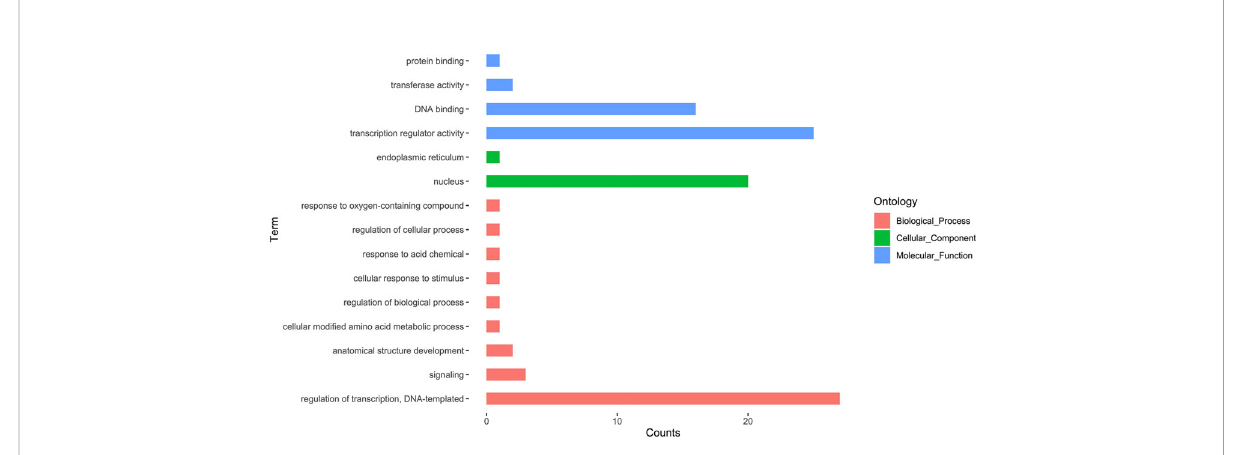
FIGURE 8 GO annotation results for the LchibZIPs from L. chinense.